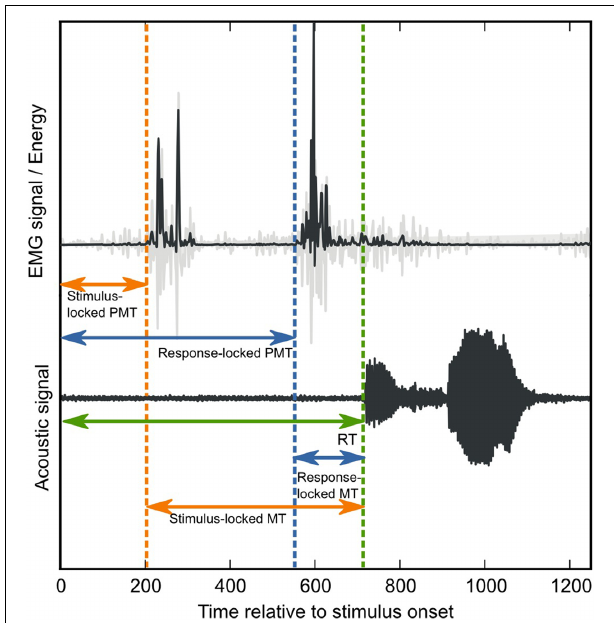
FIGURE 1 | Verbal-RT fractionation. Verbal response time (green arrow) is divided into a PMT interval, between stimulus onset and EMG onset, and an MT interval, between EMG onset and vocal-response onset. The green-dotted line indicates vocal-response onset. In order to determine EMG onsets, EMG signals (displayed in light gray) were first transformed into the TKE domain (displayed in dark gray, see also Methods). Next, EMG onsets were determined by the stimulus-locked onset-detection method (orange dotted lines) and the voice-locked onset-detection method (blue dotted lines). The effect of both methods on the PMT and MT intervals, is indicated by the length of the orange vs. the blue